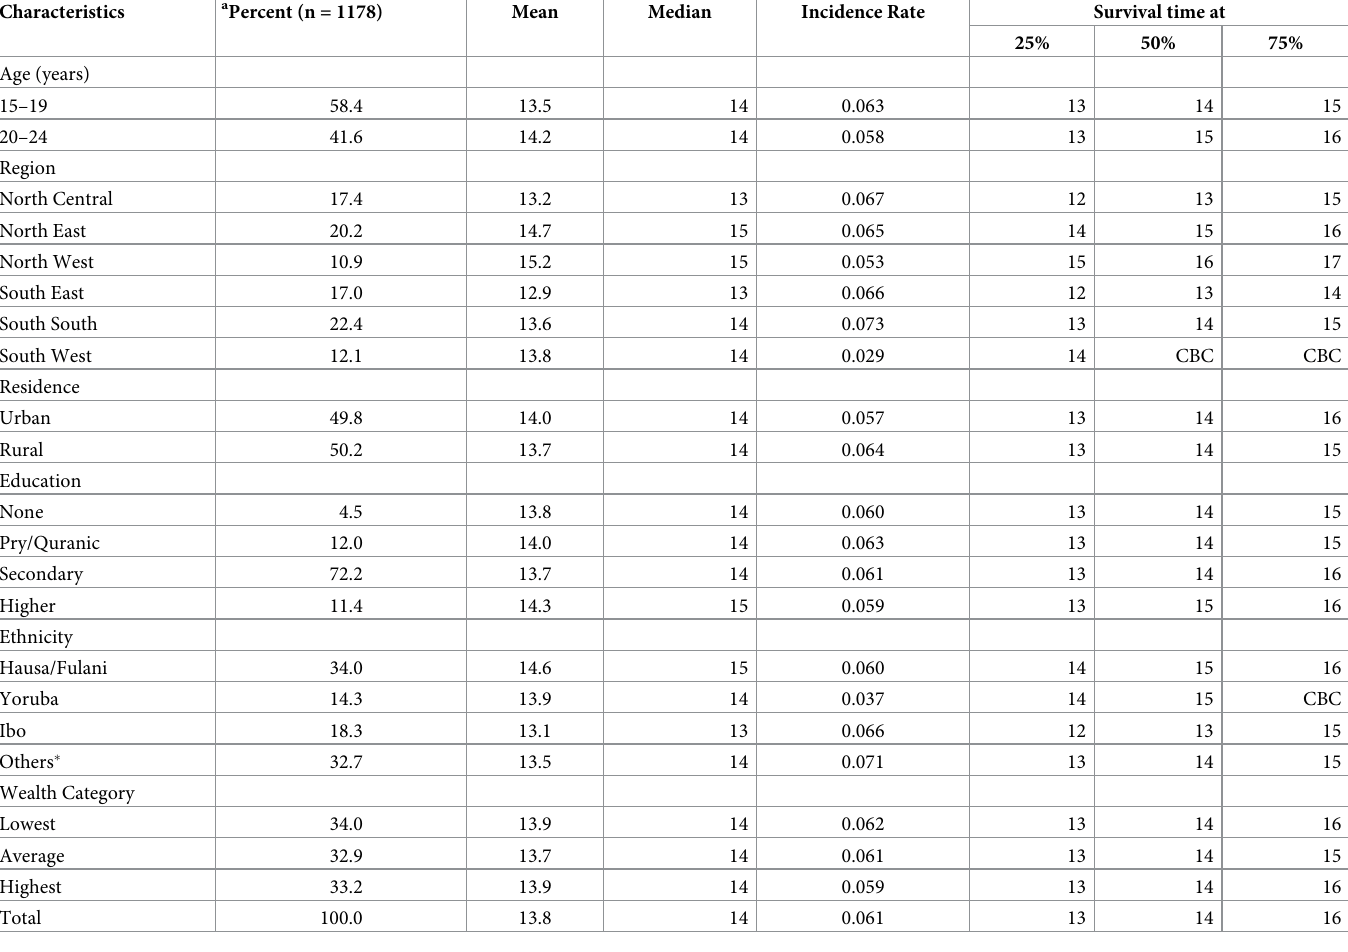
Table 1. Distribution of time to pubarche and incidence rate among males by selected characteristics.